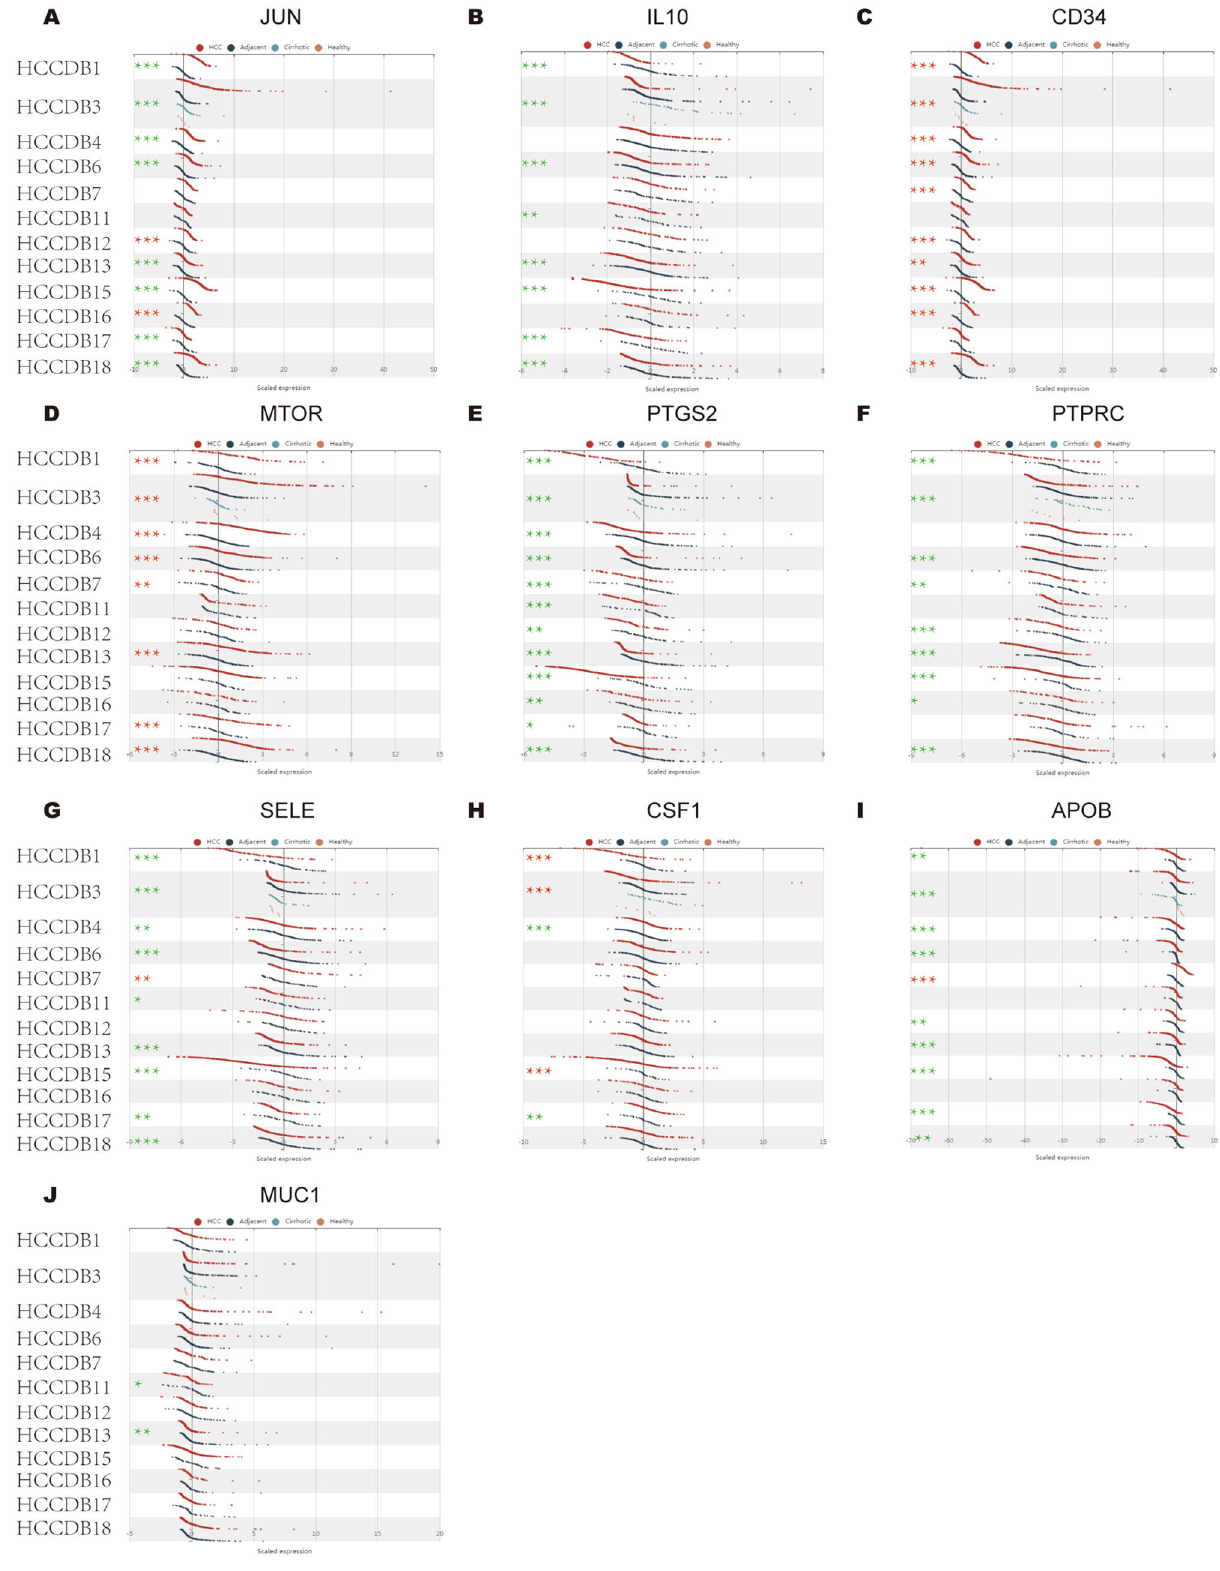
Figure 4. The relative expression of hub genes in normal and HCC samples. ( A ) JUN, ( B ) IL10, ( C ) CD34, ( D ) MTOR, ( E ) PTGS2, ( F ) PTPRC, ( G ) SELE, ( H ) CSF1, ( I ) APOB, ( J ) MUC1. *P < 0.05, **P < 0.01, ***P < 0.001. Note: Red asterisks represent upregulated genes in HCC patients, and green asterisks represent downregulated genes in HCC